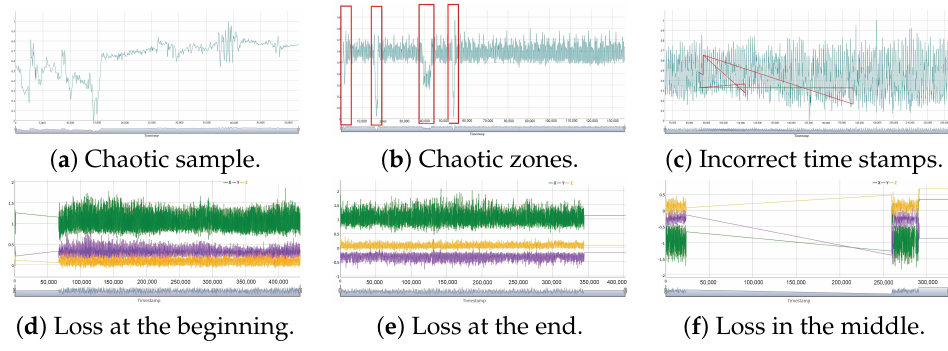
Figure A1. Problems detected in the acquired